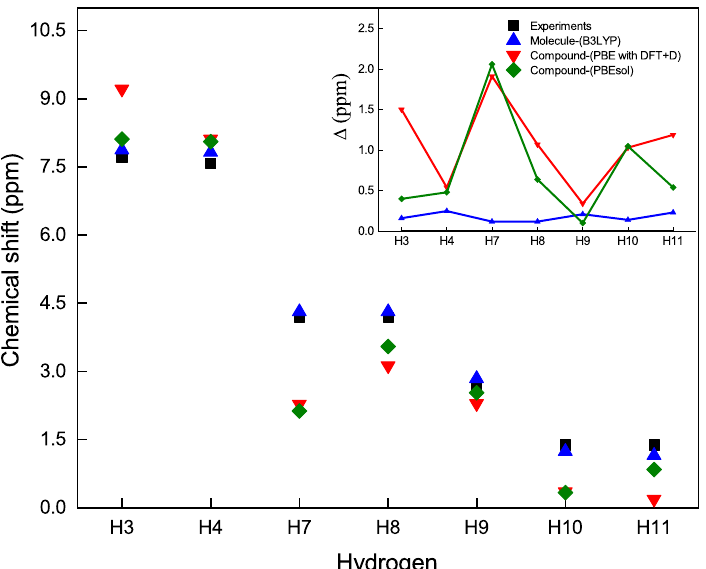
Figure 5. Chemical shift as a function of hydrogen atoms. Experimental values (black squares) of the chemical shift of hydrogen NMR-1H respect to the values calculated with different methods: B3LYP (blue triangle) in Gaussian on the molecule of the C 10 H 13 BO 3 S compound, PBE with DFT+D (red triangle), and PBEsol (diamond green) in CASTEP on the periodic lattice of the C 10 H 13 BO 3 S compound. Inset: Deviation of the theoretical values with respect to the experimental data, ∆ = | CS − CS ex | , as a function of the hydrogen th